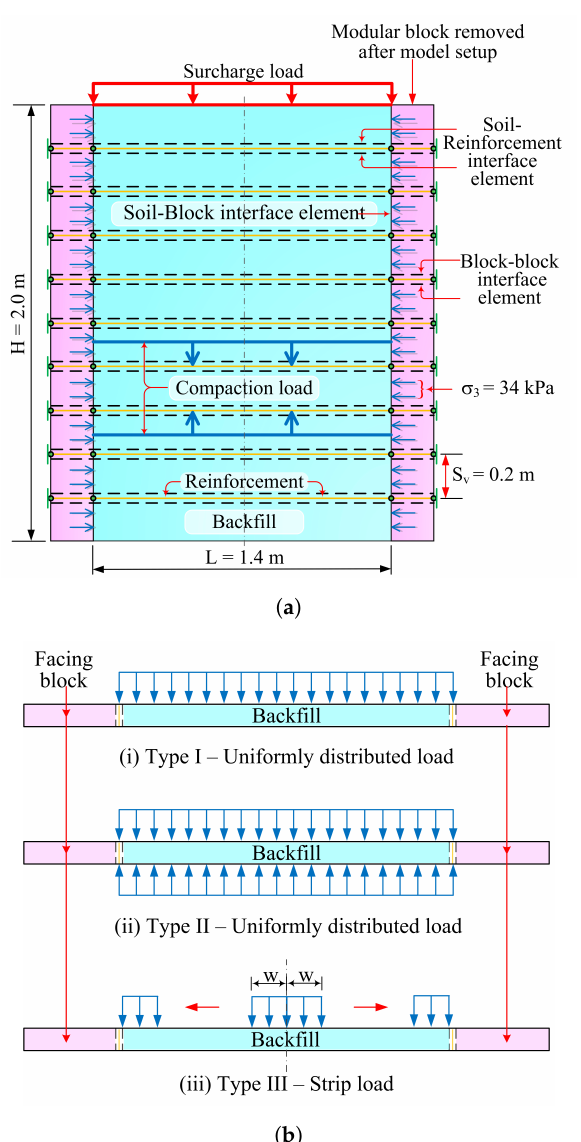
Figure 2. ( a ) Schematic diagram and configuration of Soil-Geosynthetic Composite (SGC) mass. ( b ) Simulated compaction procedures adopted for SGC mass in FE